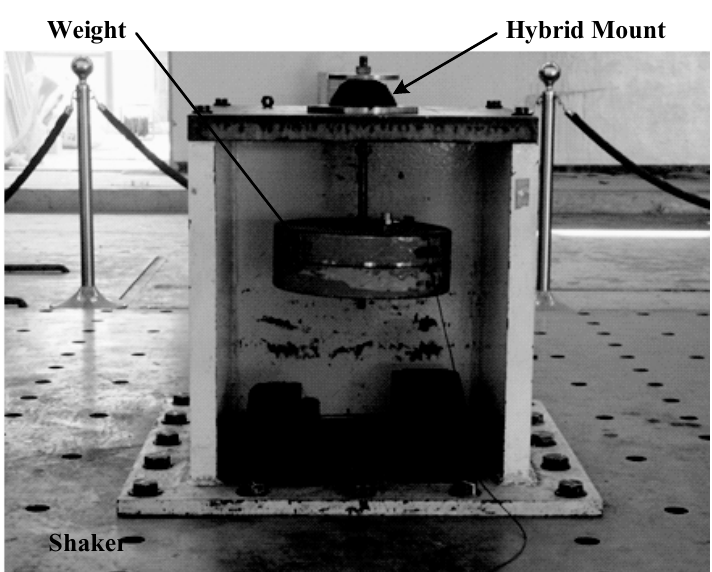
Fig. 10. Photograph of resonant frequency test for the hybrid mount.